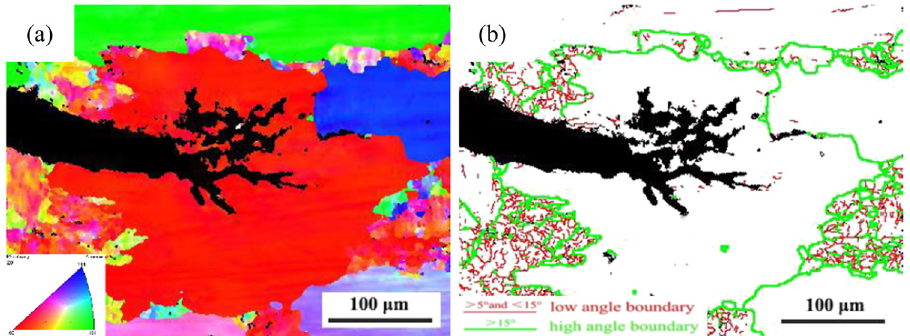
Figure 7: Stress corrosion crack propagation path of 7N01 - T4 aluminum alloy: ( a ) stress corrosion crack propagation path of base metal 7N01 - T4 aluminum alloy and ( b ) cracks crack path along grain